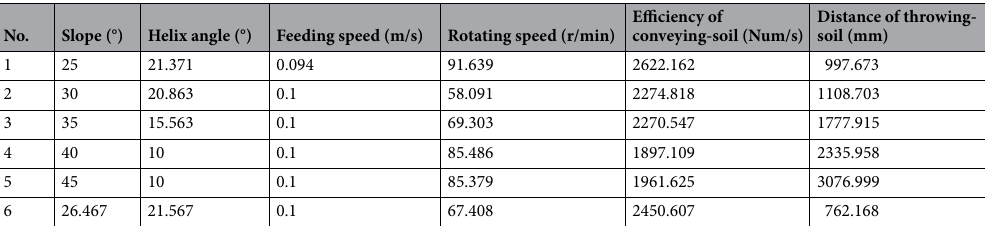
Table 6. Optimal parameter combinations of several terrain slopes.